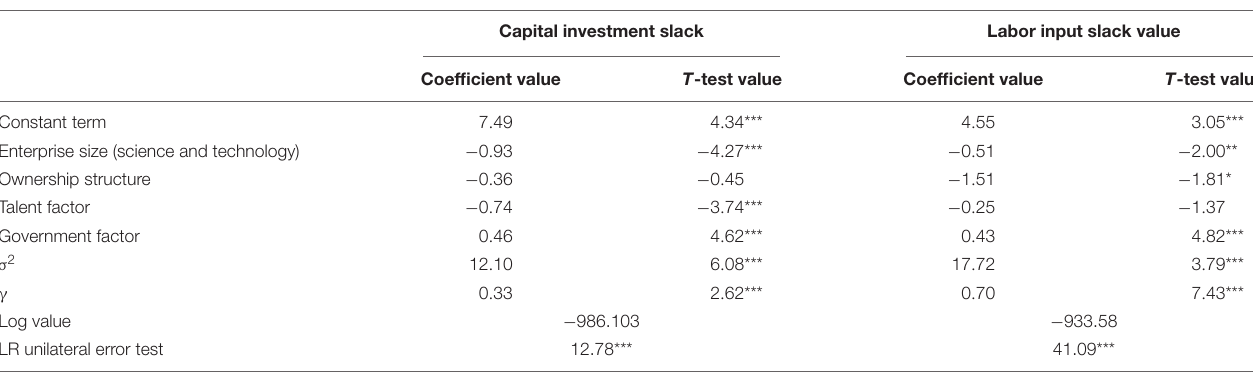
TABLE 6 | Stochastic frontier analysis regression